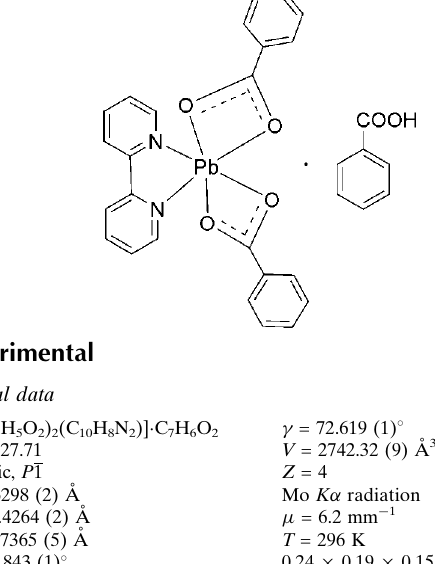
Bruker APEXII CCD area-detector diffractometer Absorption correction: multi-scan ( SADABS ; Bruker, 2007)